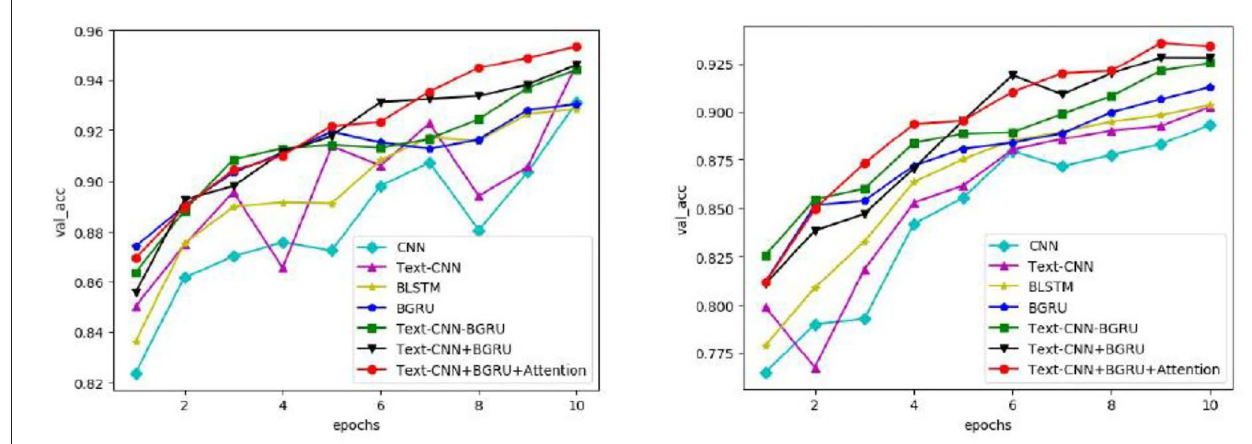
FIGURE 5 | Variation in the accuracy of the verification set for different models.